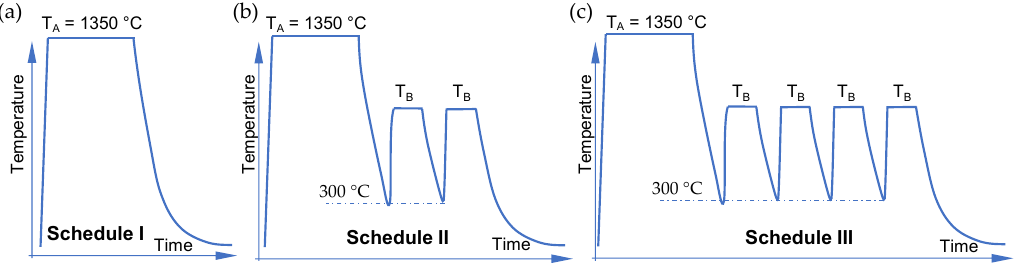
Figure 1. Applied thermal